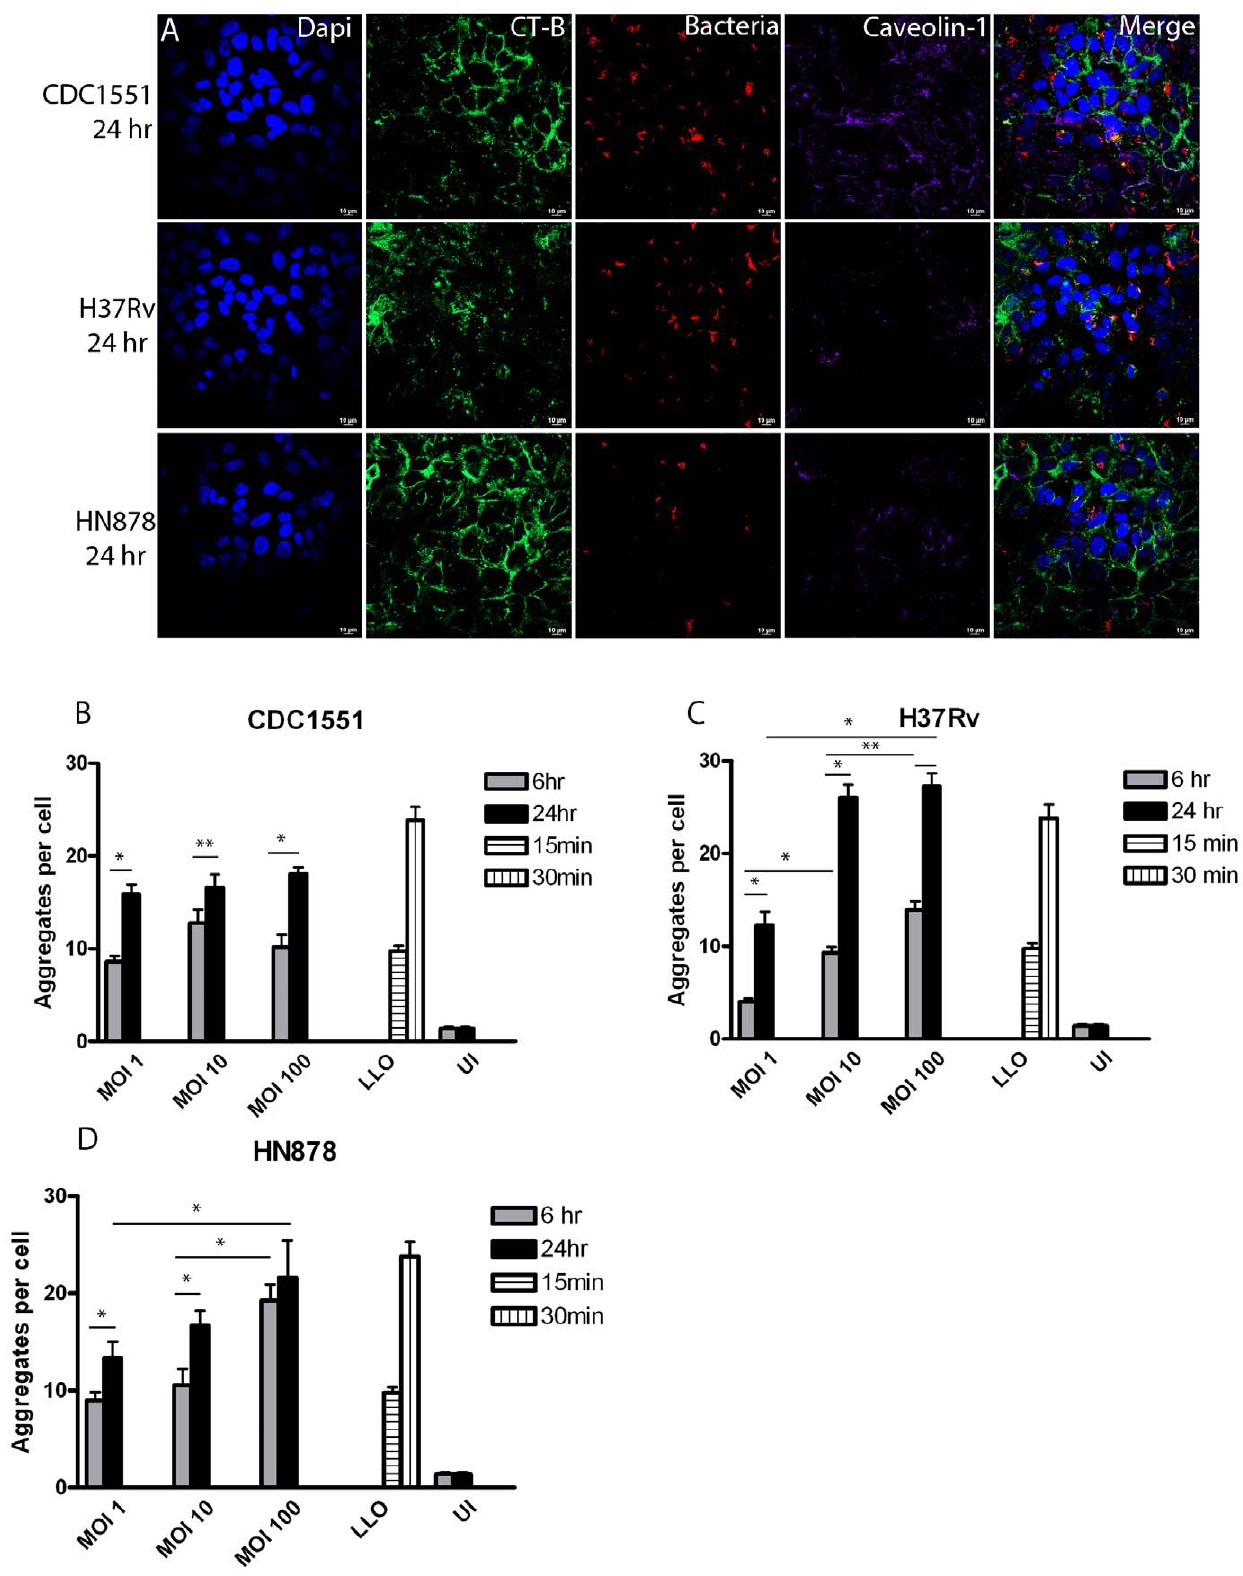
Figure 2. Mtb strains induce time- and dose–dependent increase in LR aggregation. A549 type II alveolar epithelial cells were infected at three MOI’s, 1 (Fig. S1 A), 10 (A) and 100 (Fig. S1 B) and specimens prepared for confocal microscopy as described. A549 cells treated with Listeriolysin-O (LLO) as positive controls were assessed 15 and 30 min post treatment (data not shown) Images show that infections with strain CDC1551, HN878 and H37Rv produce substantial LR aggregation at 6 hpi (data not shown) and 24 hpi (A). Quantification of microscopic images at 6